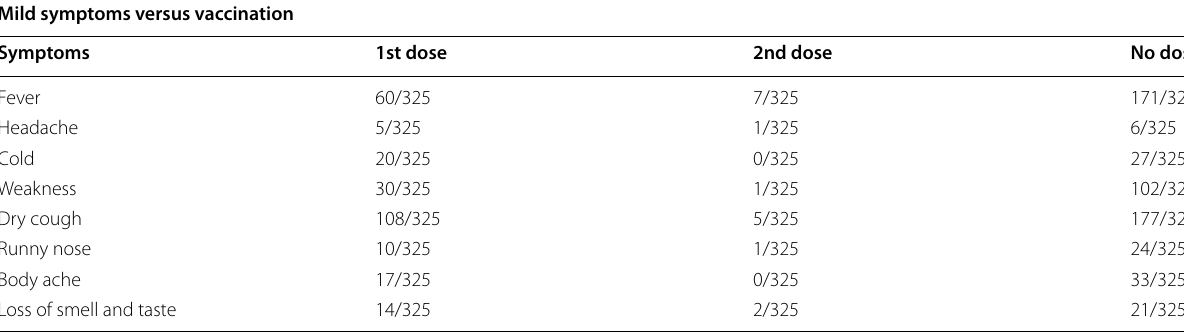
Chi-square test statistics ( p value): 27.08 (0.040) Table 2 Correlation of severe symptom with first, second, and no dose of vaccine ( p value < 0.04)